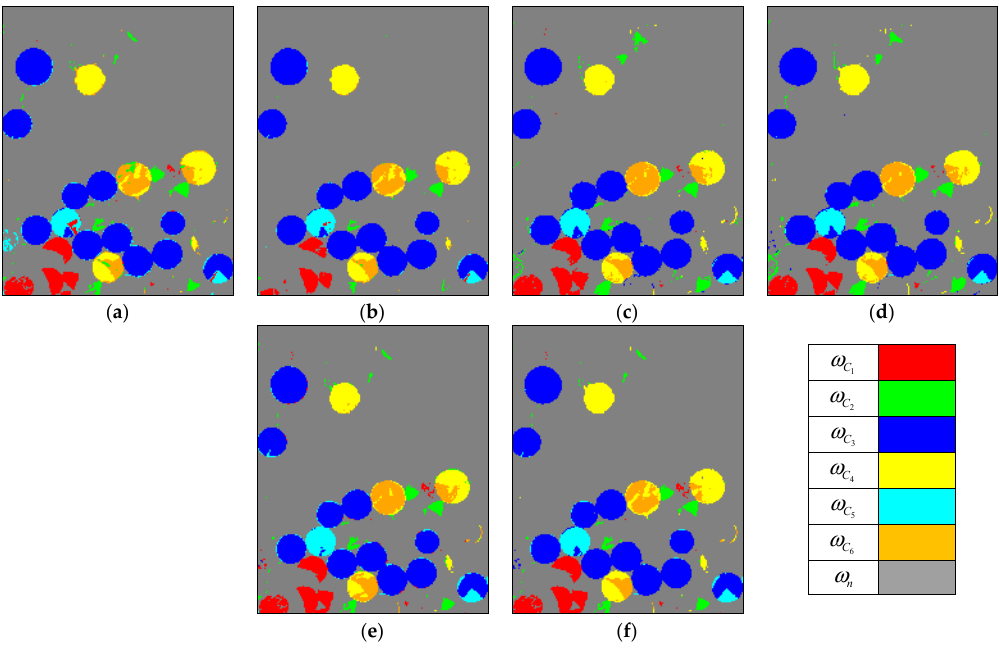
Figure 16. Binary (row 1–2) and multiple (row 3–5) CD maps obtained by the proposed CD approaches (Umatilla County dataset). The unsupervised approaches: ( a ) Bayesian-EM (or k-means for multiple CD); ( b ) FCM. The supervised approaches: ( c ) SVM-based and ( d ) RaF-based. Rows 1 and 3 are baseline results on X D , and rows 2 and 4 are results on X S with M = 20; ( e ) HSCVA; ( f ) S 2 CVA.